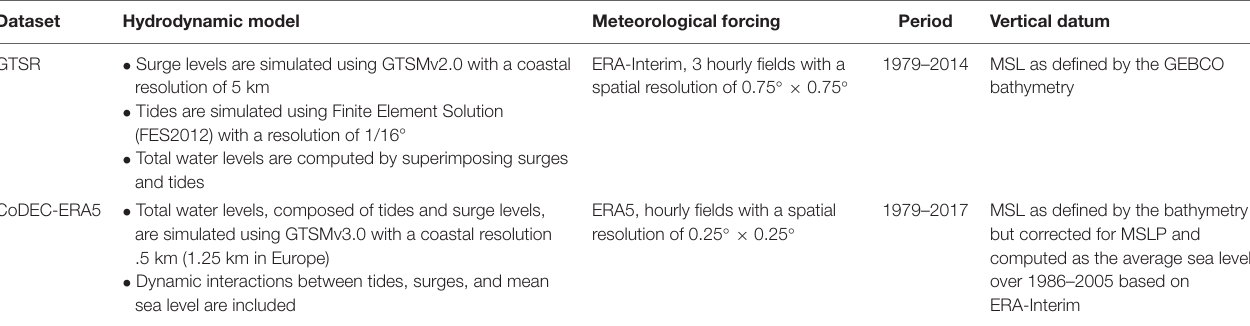
TABLE 2 | Overview of the main differences between the CoDEC-ERA5 dataset and the previous GTSR